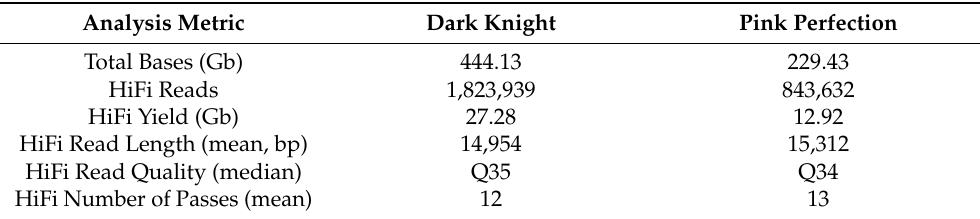
Figure 1. A principal component analysis of four different Caryopteris x clandonensis cultivars, Dark Knight, Good as Gold, Hint of Gold and Pink Perfection regarding the area of their volatile compounds analyzed by GC-MS Headspace. Table 2. Sequencing parameters of the PacBio Sequel IIe runs of Caryopteris x clandonensis cultivars Dark Knight and Pink Perfection.